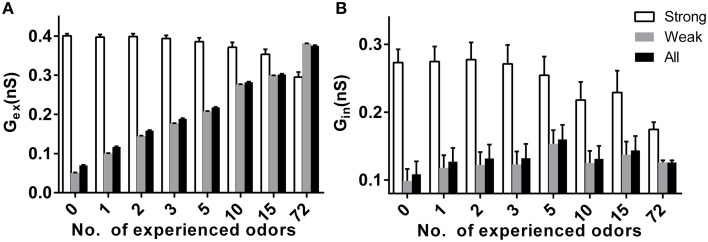
Effects of prior odor experience on synapticweightin the mitral cell network. (A) The average excitatory synaptic weight for mitral cells receiving strong (strength 3 or 4), weak (strength 0, 1, or 3), or all inputs in a variety of prior odor experience or naïve conditions. (B) Same as in (A), but for the inhibitory synaptic weight.